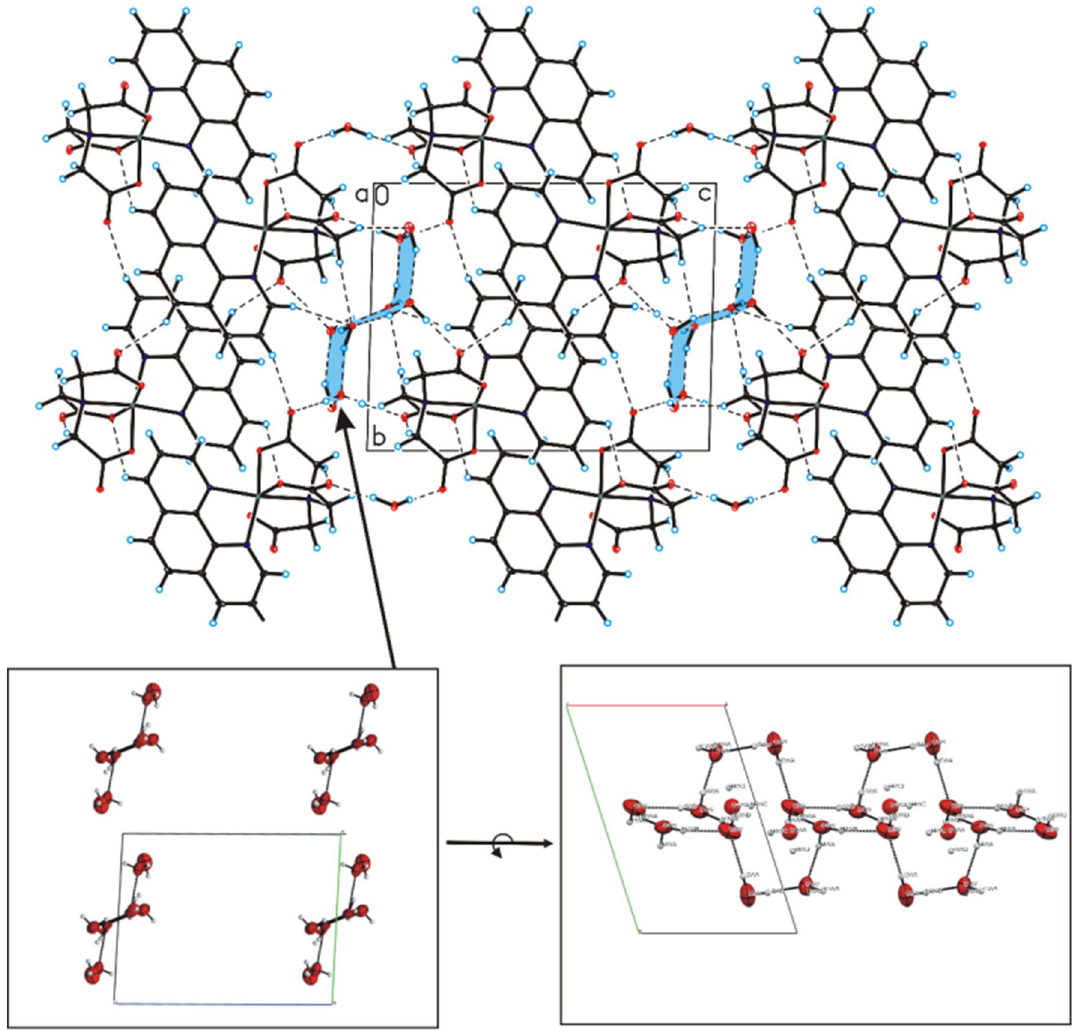
Figure 2. Crystal packing of (nitrilotriacetato-1,10-phenanthroline)chromium(III) tetrahydrate viewed along a